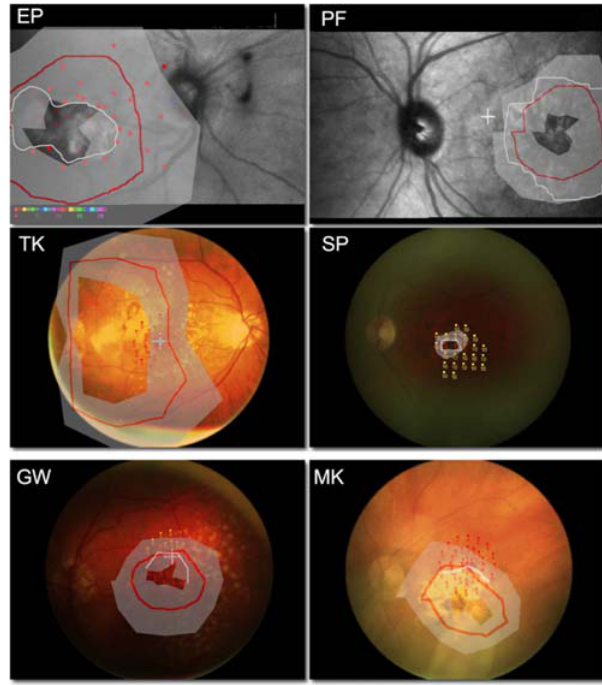
Figure 2. Scotomas identified by the dynamic after effect. Red line represents mean scotoma boundary; grey region indicates 95% confidence interval of estimate. White line represents boundary of dense scotoma identified from microperimetry assessment (except subject TK where scotoma is larger than the area measured using microperimetry, and GW and MK where only the upper boundary of the scotoma could be identified). Where present, white cross indicates centre of fixation. EP, PF: microperimetry performed using Rodenstock SLO-101 scanning laser ophthalmoscope. TK, SP, GW, MK: microperi- metry performed using Nidek MP-1 microperimeter.